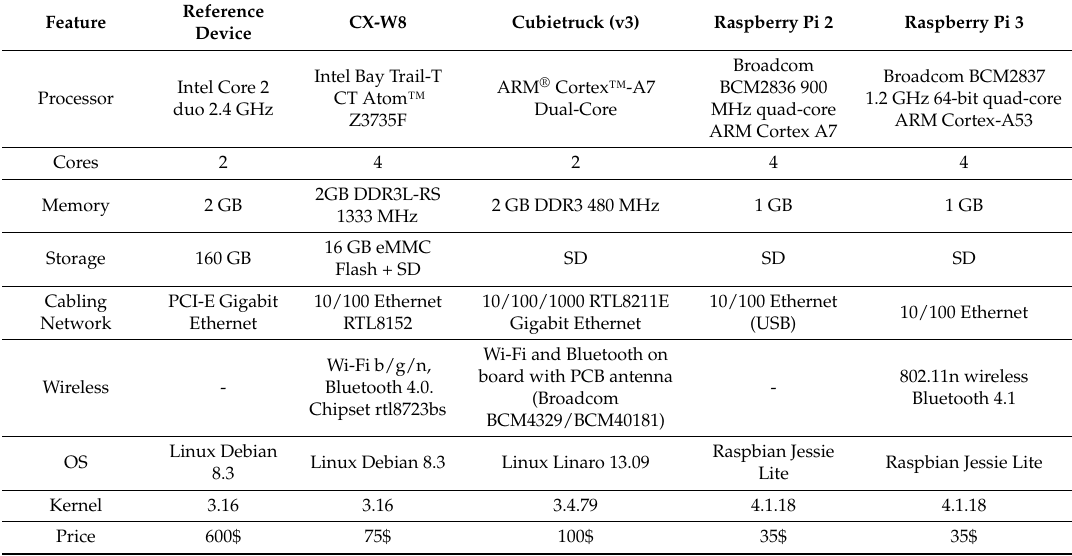
Table 3. Characteristics of each prototype. SD: secure digital; and USB: universal serial bus.